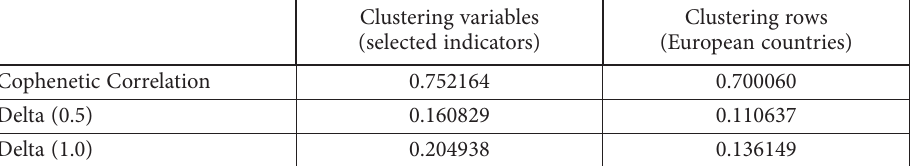
Table 4: 0.75 in the case of variables and 0.70 in the case of rows, the results are considered optimal for this type of quantitative analysis. Table 4. Double dendrograms – clustering validation tests (source: authors’